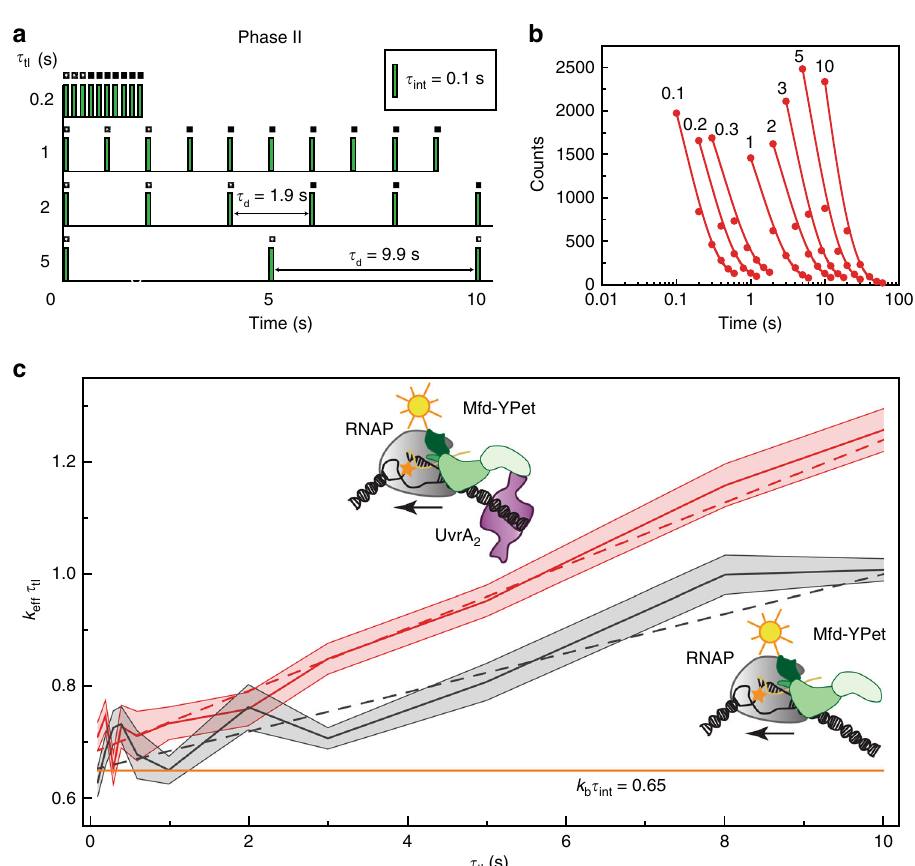
Fig. 4 Kinetics of association of Mfd-YPet with RNA polymerase in live cells. a Intracellular off-rate constants of Mfd-YPet were measured using an interval imaging scheme. Imaging was performed in two phases: in the fi rst phase, continuous illumination was applied to bleach the signal followed by a reactivation phase (shown here) where photo-reactivated molecules were visualized. In this imaging scheme, a dark frame with a varying duration ( τ d ) was inserted between consecutive acquisition frames (green bars, τ int = 0.1 s) in phase II (reactivation phase). Time-lapse time ( τ tl ) is the sum of τ int and τ d . b Cumulative residence time distributions of Mfd-YPet foci in mfd-ypet uvrA + for various time-lapse times ( τ tl ; values are indicated above each trace). Red circles represent combined observations from nine independent experiments. Effective off-rate constant ( k eff ) is obtained from the exponential fi t (line) to the experimental data at each time-lapse time. c k eff τ tl vs. τ tl plot for the determination of the off-rate constants ( k off ) of Mfd-YPet in mfd-ypet uvrA + (red curve) and mfd-ypet Δ uvr A (grey curve) cells. Shaded error bars represent standard deviations of the bootstrap distribution of k eff τ tl for the corresponding τ fi ts to the corresponding data. The orange line (continuous) represents a hypothetical static binding with k tl . Dash lines represent linear least squares off equal to zero and k b τ int equal to 0.65. Cartoons (insets) represent possible Mfd-RNAP complexes forming in mfd-ypet uvrA + (top) and mfd-ypet Δ uvr A (bottom)